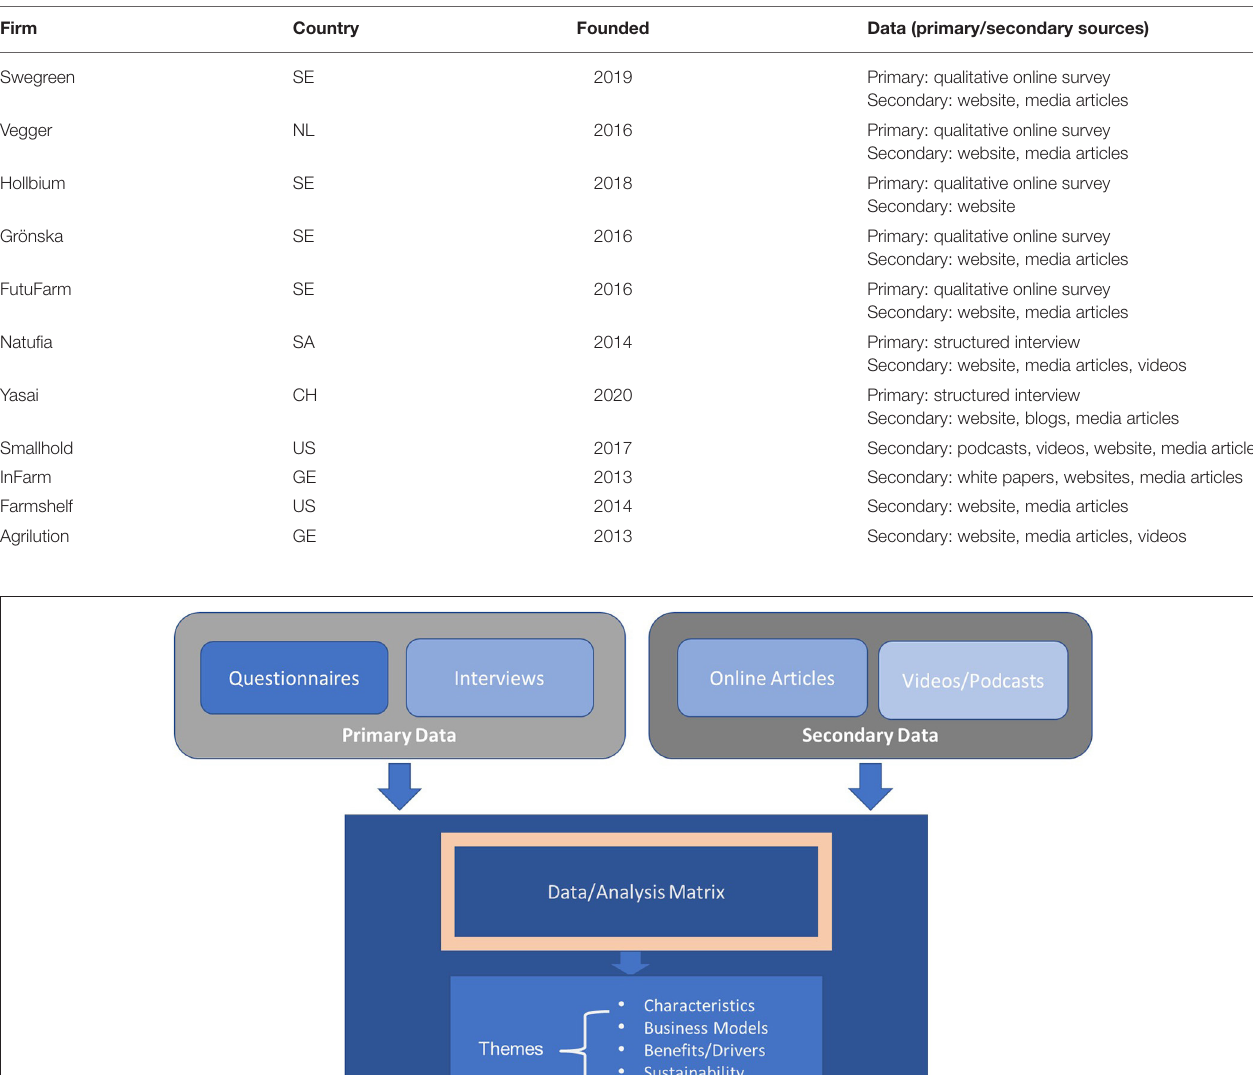
TABLE 1 | Overview of firms analyzed.